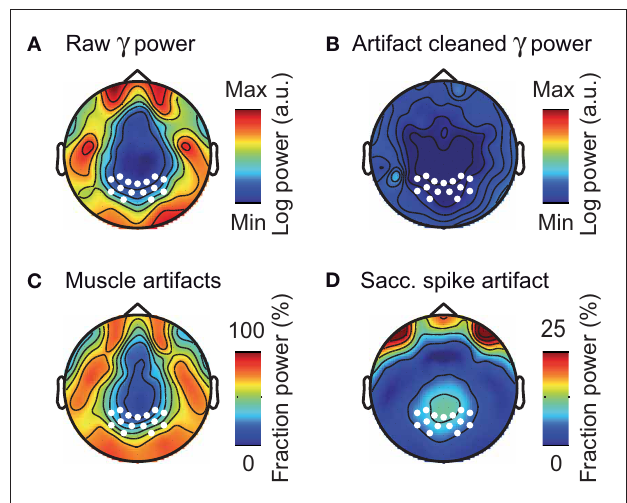
Bonferroni corrected for time and frequency). Right: scalp topography of power responses in the time-frequency range − 0.65 to 0.05s and 50–110Hz. (B,D) Left: power response relative to prestimulus baseline resolved in time and frequency for an occipito-parietal source region of interest (see insets for the region of interest; CS: central sulcus). Right: spatial power distribution in the time-frequency range indicated by the dashed box in the left panels.